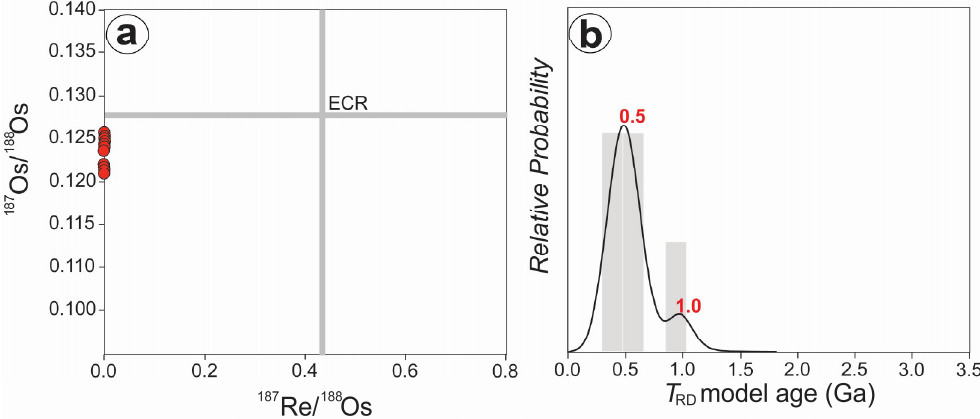
Figure 6. Re-Os isotope systematics in the analyzed laurites (n = 24 grains) of the North Andaman chromitites in terms of: ( a ) Isotopic ratios 187 Re/ 188 Os and 187 Os/ 188 Os; ( b ) Cumulative-probability plots and histograms (shaded bars, relative probability) of Os model ages (Ga) where uncertainties artificially were increased to 0.1 Ga to allow for uncertainty in the enstatite chondritic reservoir (ECR) model-age reference curve. This plot is most appropriate for estimates of the absolute depletion ages of different mantle domains, and for comparison between datasets from platinum-group minerals (PGM) and base-metal sulfides (BMS).